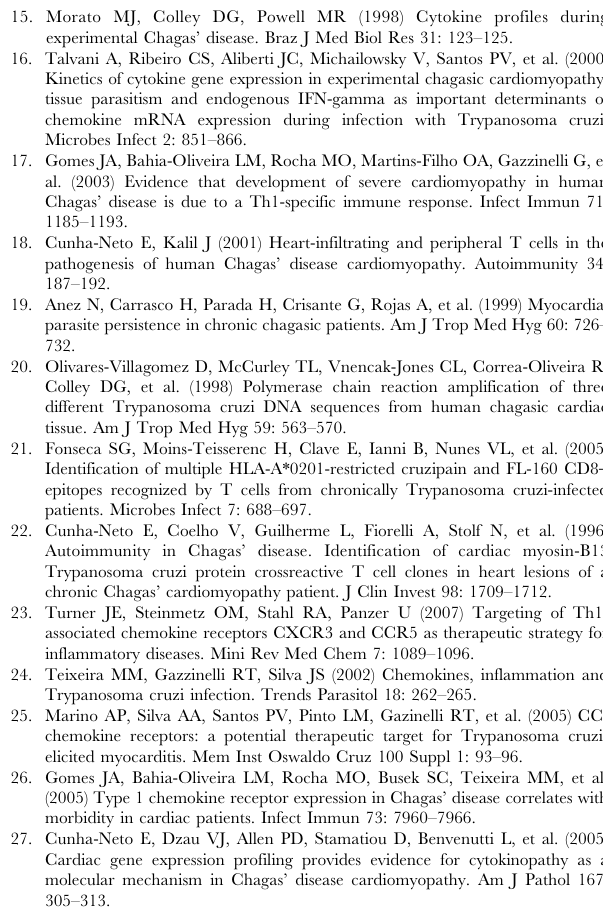
Table S2 Characteristics and Minimal Allele Frequency of tested SNPs. Table S3 Relative expression values of 14 genes ana- lyzed in different sites of left ventricular free wall samples from three CCC patients, CCC-7, CCC-9 and CCC-10. Table S4 Genotype and allele frequencies for the CCL4 rs1719153 polymorphism in patients with Chagas dis- ease. CCC patients were further stratified by left ventricular ejection fraction values. Table S5 Genotype and allele frequencies for the CCL5 rs2107538 polymorphism in patients with Chagas dis- ease. CCC patients were further stratified by left ventricular ejection fraction values. Table S6 Genotype and allele frequencies for the CXCR3 rs2280964 polymorphism in patients with Cha- gas disease. CCC patients were further stratified by left ventricular ejection fraction values. Table S7 Genotype and allele frequencies for the CCL19 rs3136658 polymorphism in patients with Chagas